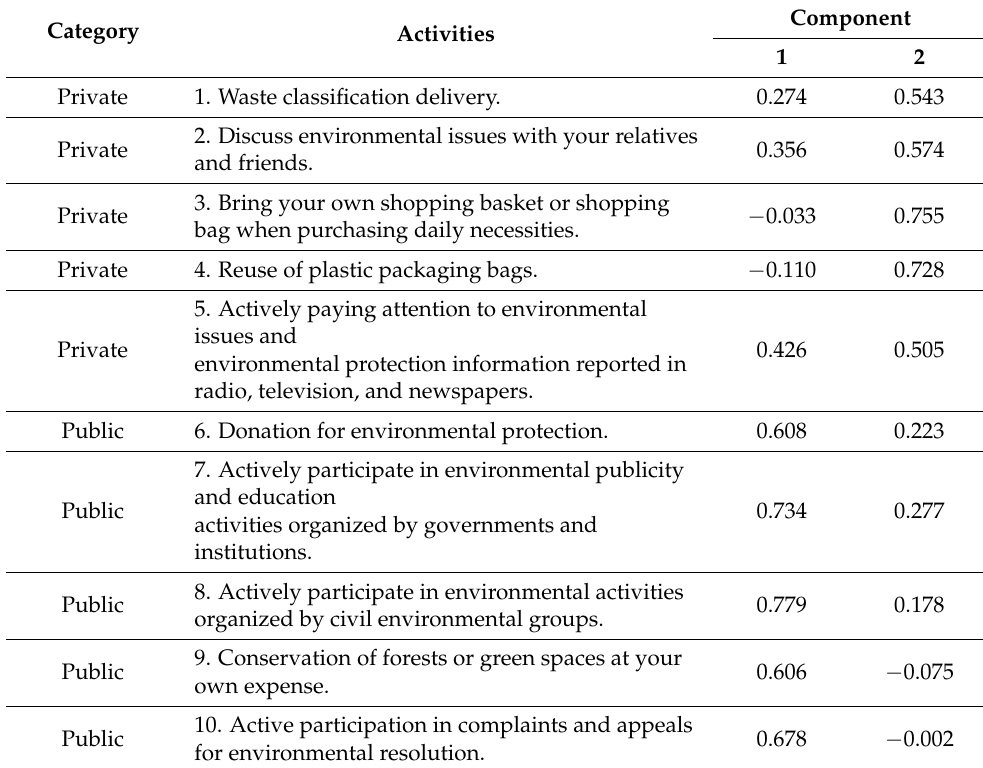
Table 2. Environmental behavior scale.